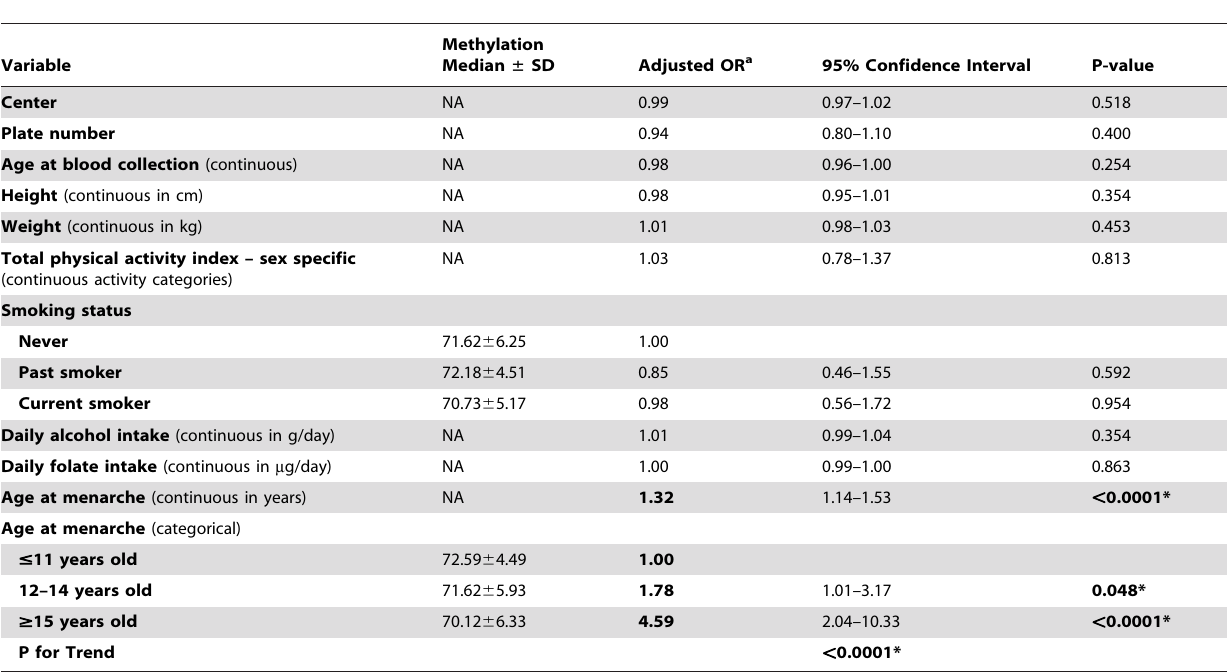
Table 3. Logistic Regression for percent genome wide methylation (LUMA levels below vs. above median) by age at menarche as a categorical variable and other relevant